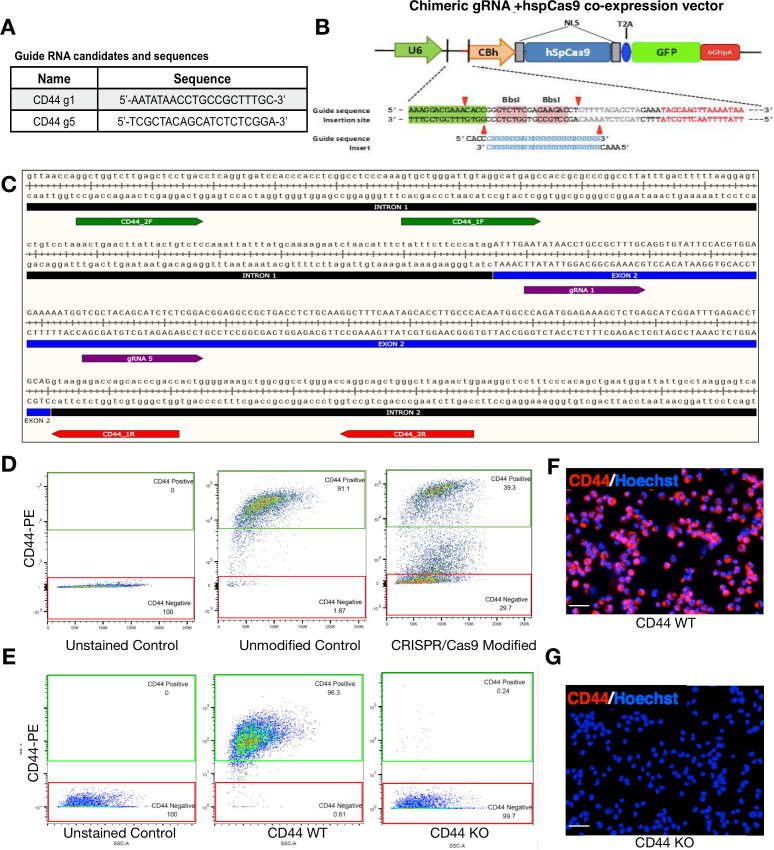
WT and CD44 KO hNSC generation.The human CD44 loci (gene ID: 960) was targeted using the CRISPR/Cas9 system to create genetic knockout via non-homologous end joining (NHEJ). (A) CD44 Guide RNA sequences. For maximum disruption of CD44’s ORF, two guide RNAs (gRNAs) were simultaneously introduced into hNSC with chimeric guide RNA + hspCas9 co-expression vector. (B) hspCas9 co-expression vector. (C) Snap Gene Graphics for gRNA alignment. Both gRNAs (purple) were designed to target the second exon of CD44 to generate a 47 bp deletion within exon two resulting in a frame-shift that introduces a pre-mature stop codon within a targeted exon. (D) WT and CD44 KO FACS sorting after CRISPR. Two weeks after plasmid introduction, unsorted CRISPR-modified hNSC were separated based on CD44 expression using fluorescence activated cell sorting (FACS); CD44-negative knockout cells (29.7% of the total population) were isolated based on the gating of our unstained control; CD44-positive wild-type cells (39.3% of the total population) were isolated based on the gating of our positive control, unmodified CD44-PE-stained cells. FACS-isolated CD44 WT and CD44 KO hNSC retain expression identity after multiple passages. (E) Flow citometry analysis of CD44 WT and KO hNSC. After more than a month in culture, and having undergone four passages, we re-analyzed the expression of CD44 in WT and KO cells. FACS-isolated CD44 WT hNSC retained CD44 expression; 96.3% CD44-PE positive and 1.87% CD44-PE negative. FACS-isolated KO hNSC retained a CD44-negative expression phenotype; 99.7% CD44-PE negative and 0.24% CD44-PE positive. (F) Fluorescent images of CD44 WT immediately after flow cytometry. (G) Fluorescent images of CD44 KO immediately after flow cytometry. After CD44 -PE staining, hNSC were counterstained with Hoechst to label cell nuclei and then mounted on a slide using a Cytospin 4 centrifuge (Thermo Scientific). Scale bars 30 µm. Images were taken in an inverted fluorescent microscope at 20×.